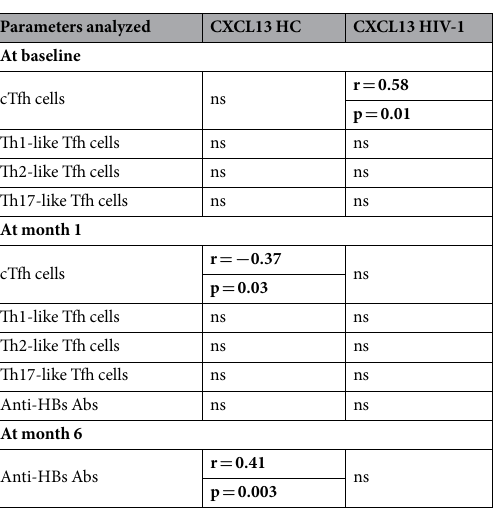
Table 1. Correlation of plasma CXCL13 with sub-populations of Tfh cells and antibodies to HBV vaccine. HC = healthy children; ns = not